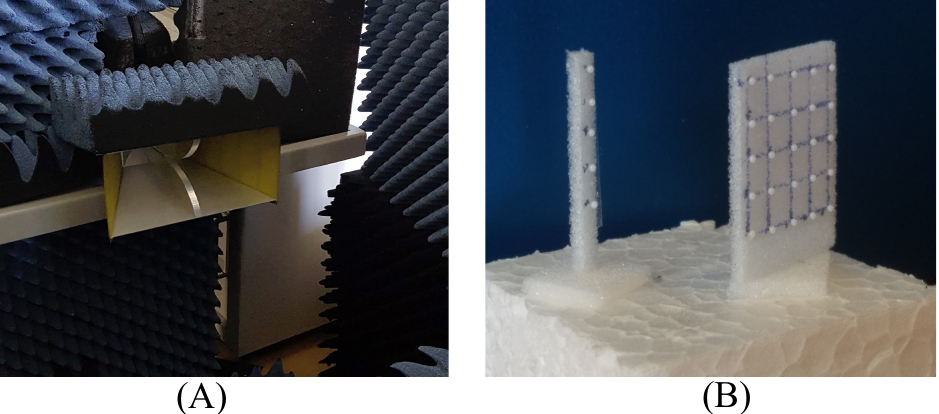
Figure 4. The measurement setup. ( A ) Double ridge horn. ( B ) 5 × 5 and 5 × 1 DR array configurations.